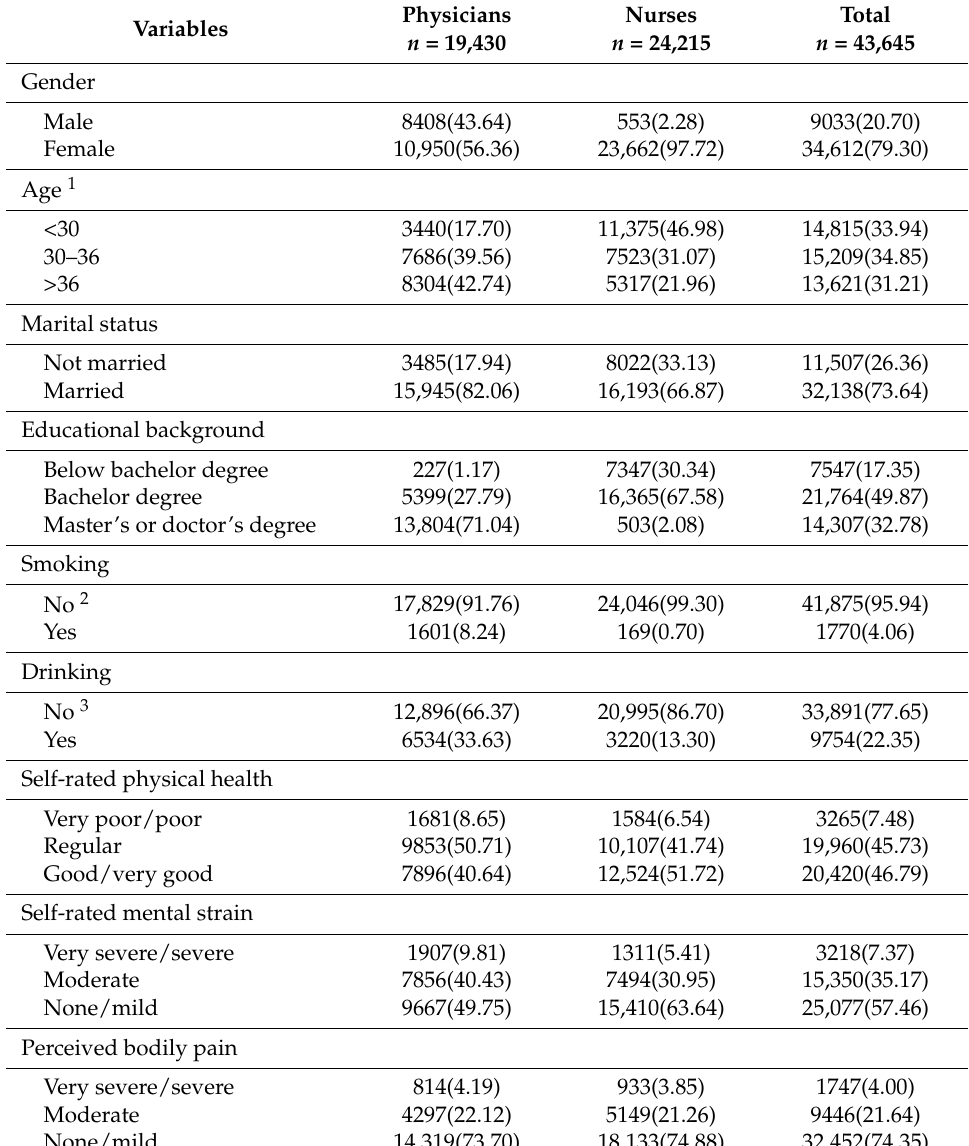
Table 2. Individual characteristics of respondents, n (%).